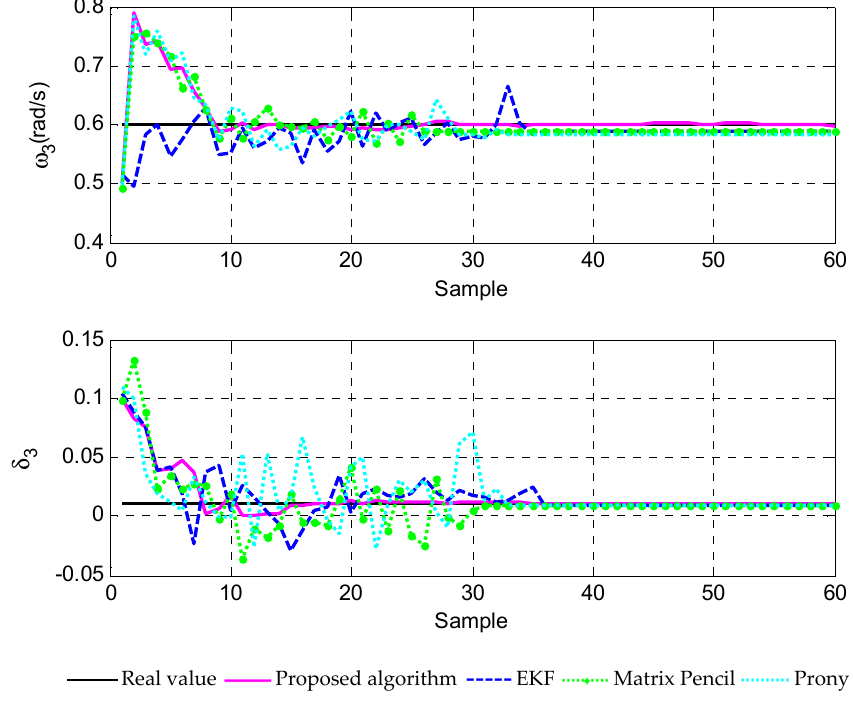
δ by using different methods. 3